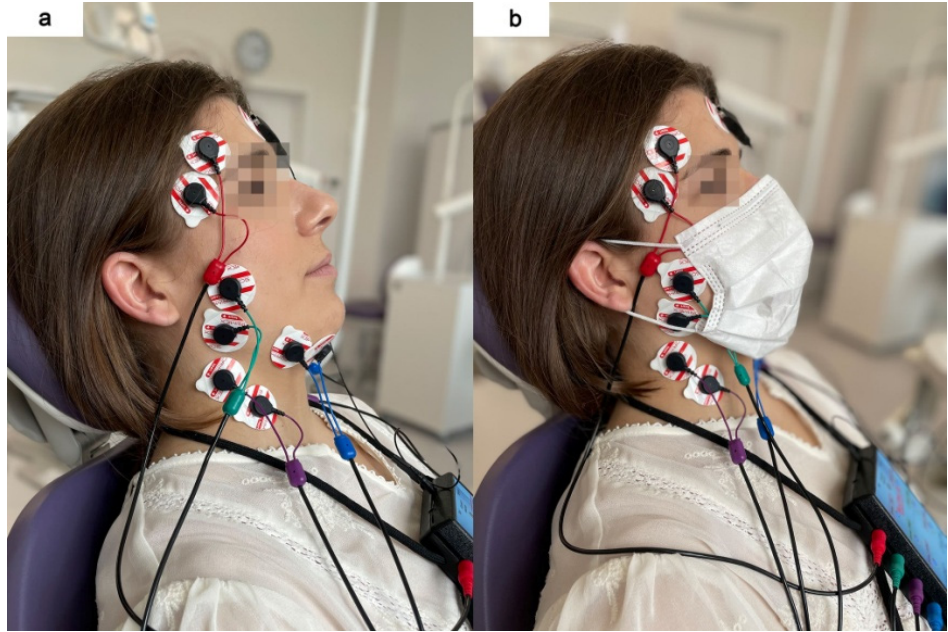
Figure 1. Electromyographic examination during two conditions: without ( a ) and with medical mask ( b ).